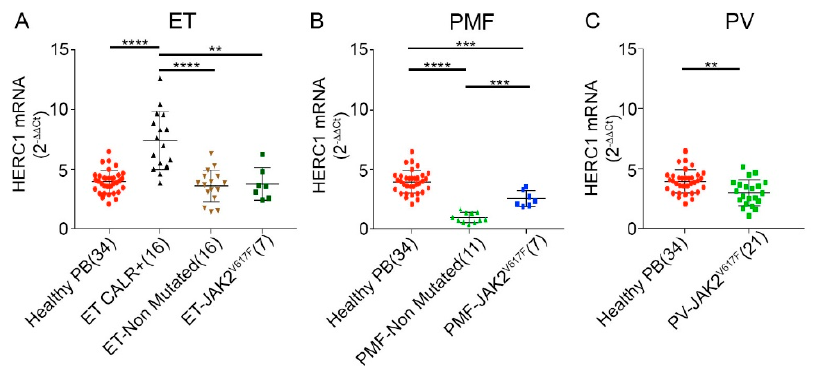
Figure 3. HERC1 mRNA is differentially and peculiarly expressed in MPNs patients. On the whole, the expression pattern of HERC1 in MPNs appeared to be rather scattered and variable. Among MPNs, when compared to the healthy subjects, the CALR mutated Essential Thrombocythemia (ET) specimens ( A ) displayed a significantly higher amount of HERC1 transcript, ( p ≤ 0.0001). On the contrary, the JAK2 mutated, and non-mutated, specimens showed levels comparable to the control counterpart. ( B ) Differently, the Primary Myelofibrosis (PMF) patients displayed a rather steep downregulation of HERC1 gene expression. However, the JAK2V617F mutated samples showed higher HERC1 levels in comparison to the mutation free cohort. ( C ) In Polycythemia Vera (PV) patients the HERC1 mRNA level was slightly, but significantly, lower than that of the healthy subjects (** p < 0.01, *** p < 0.001, **** p < 0.0001).